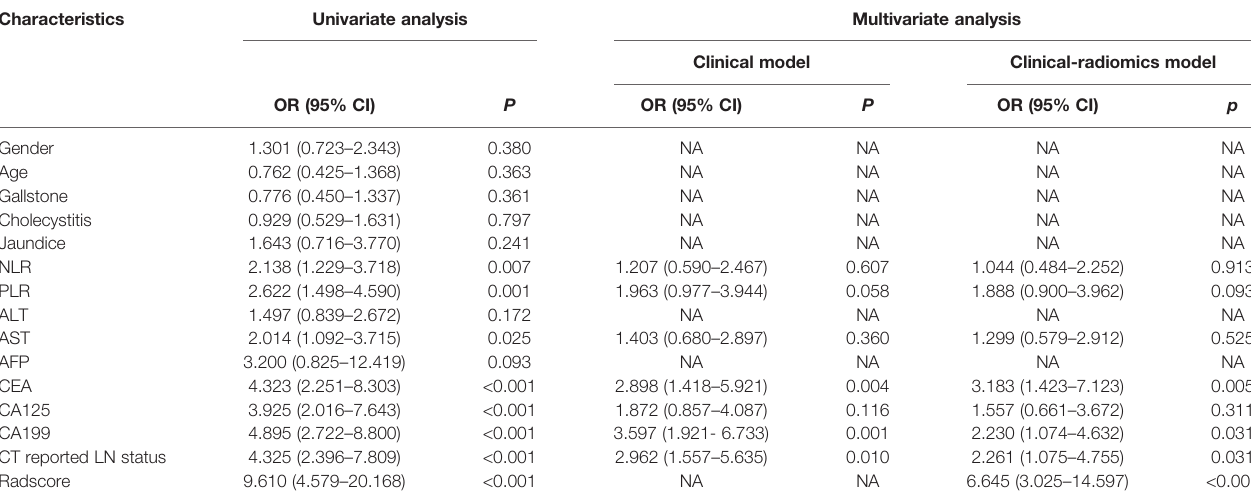
TABLE 2 | Univariate and multivariate logistic regression analysis for LN metastasis in the primary cohort.